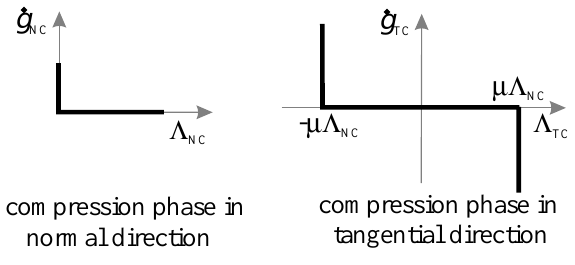
Fig. 6. Contact law for the compression phase.